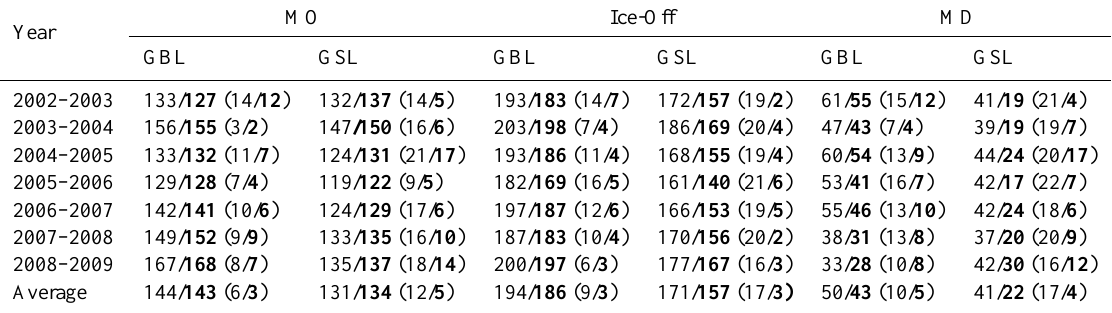
Table 4. Summary of ice phenology variables during the break-up period (average day of melt-onset (MO) and ice-off, and number of days of melt duration (MD)) for GBL and GSL (2002-2009). Values within confidence regions in bold. Standard deviation in parentheses.